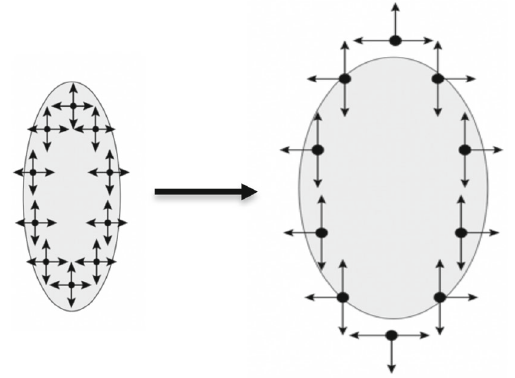
Fig. 4 Schematic representation of buildup of negative elliptic flow at low p T . The anisotropic expansion of the medium along x -axis leads to more suppression of low p T bottomonium states along the x -axis compared to y -axis due to states being overtaken by the expanding QGP model calculations and CMS results are for the 5–60% cen- trality class and at mid-rapidity ( | y | < 2 . 4), while the ALICE measurements are for the same centrality interval but at for- ward rapidity (2 . 5 < y < 4 . 0). Our calculations predict a negative v 2 for low p T , which could be explained as follows.